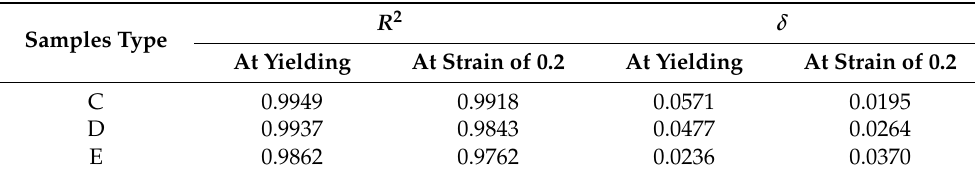
Table 6. Absolute error ( δ ) and correlation coefficient ( R 2 ) for the correlation of experimental and predicted values of yield stress for various forms of DMLS Ti6Al4V(ELI). Samples